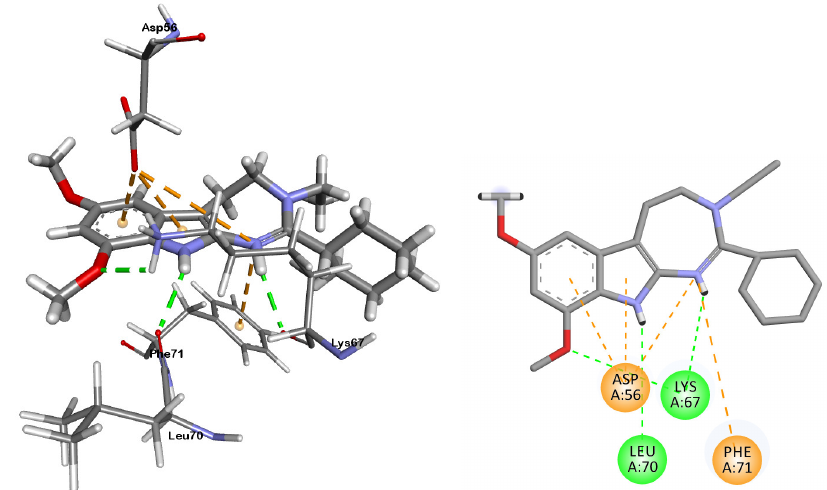
Figure 3. 3D (left) and 2D (right) representations of the docked pose for compound 2_4. Green dotted lines represent hydrogen bonds and orange dotted lines π- ion interactions.